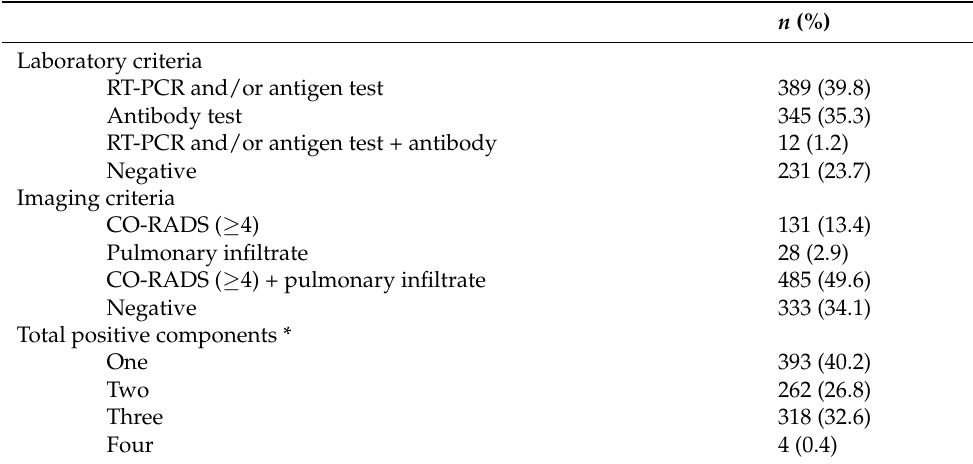
Figure 2. Flowchart of death record identification and selection process. Table 1. Evaluation of the criteria used to define a COVID-19 death ( N =